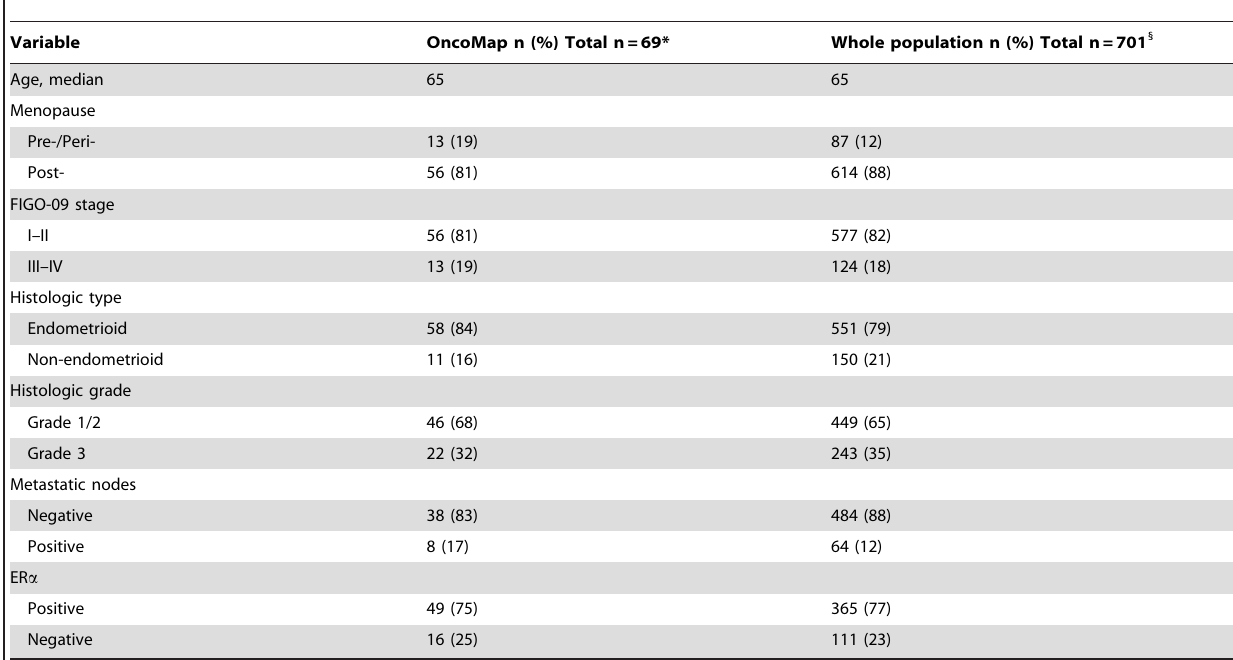
Table 2. Clinico-pathologic characteristics of 69 endometrial cancer patients screened in OncoMap compared to the whole population from the same